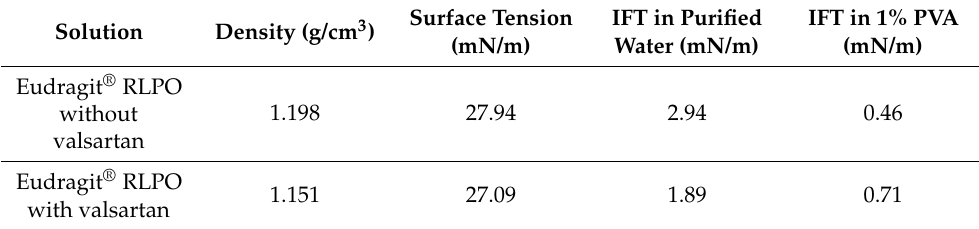
Table 3. Density, surface tension, and IFT of the polymer in MilliQ water and in 1% PVA solution in presence and absence of valsartan. Surface Tension IFT in Purified IFT in 1% PVA Solution Density (g/cm 3 ) (mN/m) Water (mN/m) (mN/m) Eudragit ® RLPO 1.198 27.94 2.94 0.46 without valsartan Eudragit ® RLPO 1.151 27.09 1.89 with valsartan